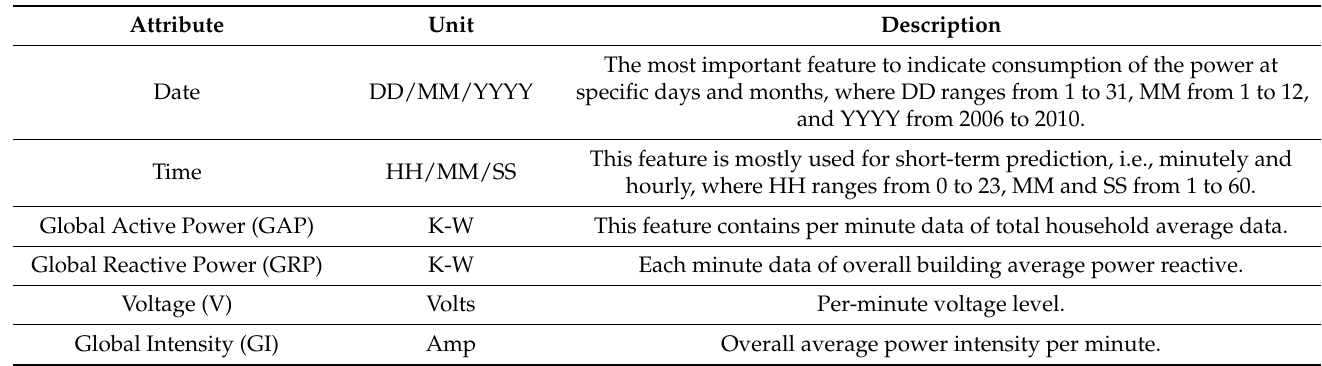
Table 1. Common attributes, units, and their description of the datasets used for the evaluation of the proposed model. Attribute Unit Description